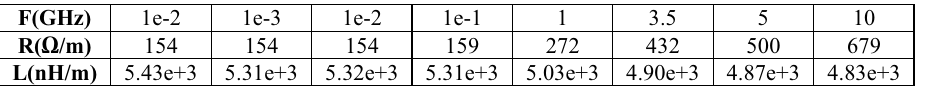
Table 1. Per unit length and resistance parameters of the coupled transmission line